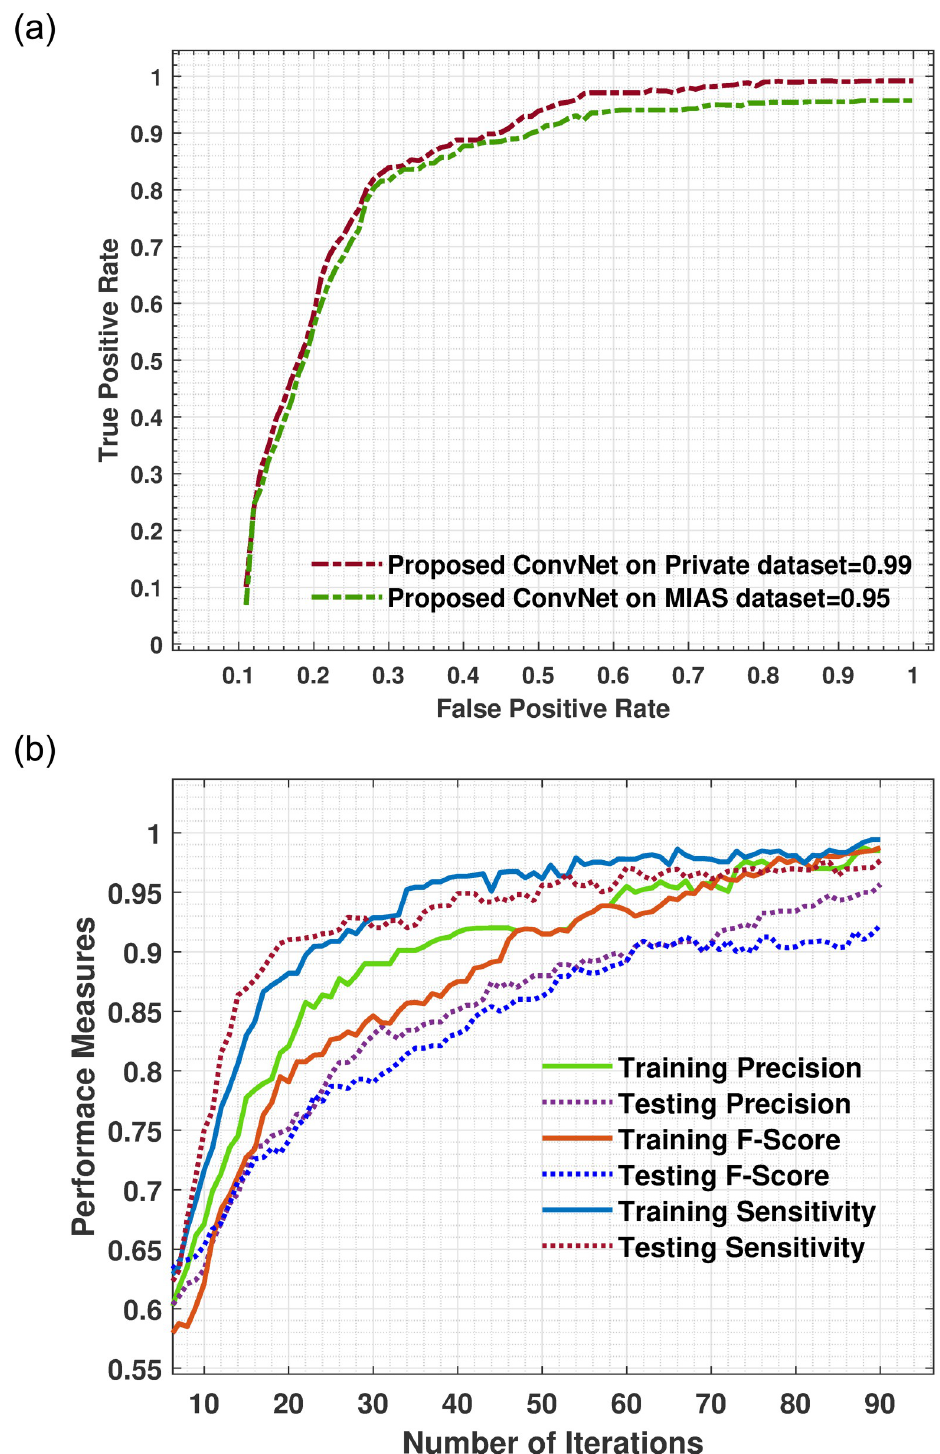
Fig 7. (a) Represent the training and testing area under the curve of the proposed model using Private dataset and MIAS datasets. The graph shows that the proposed model has attained a maximum AUC of 0.99. The experimental findings indicate that the suggested model yields a small number of false positives and high true positives. (b) Training and testing precision, F-score and sensitivity of proposed model using Private dataset. The proposed model has performed well by attaining an excellent sensitivity of